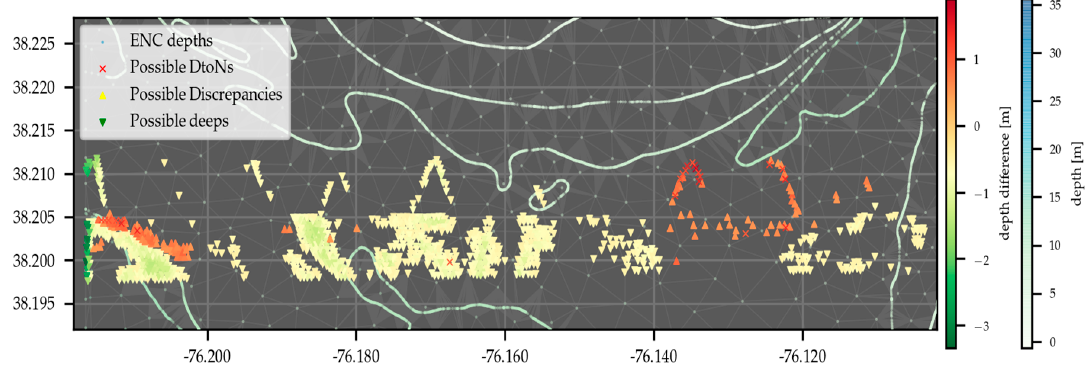
Figure 11. Algorithm results using the western part of the H12990 survey soundings compared to the US5VA21M ENC. Axes in geographical WGS84 coordinates.